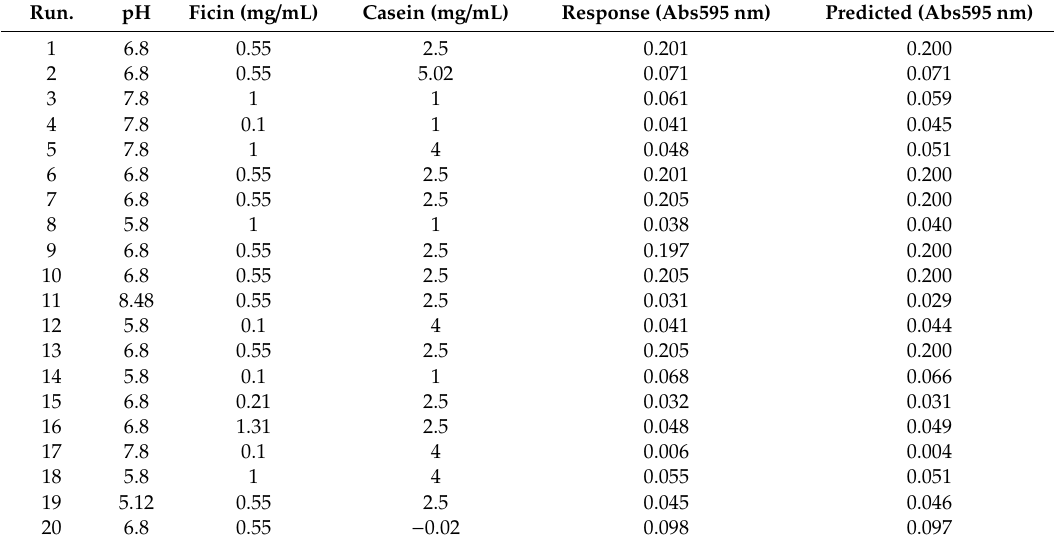
Table 2. CCD experimental matrix generated by the Design expert software and the corresponding responses (actual and predicted).